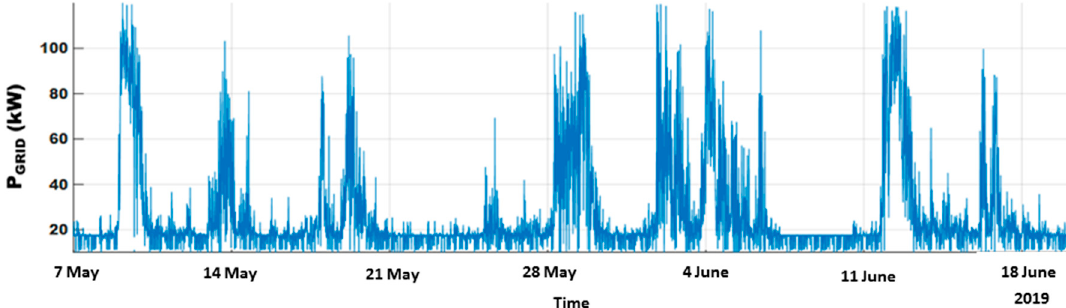
Figure 15. Power profile delivered to the grid throughout the generation